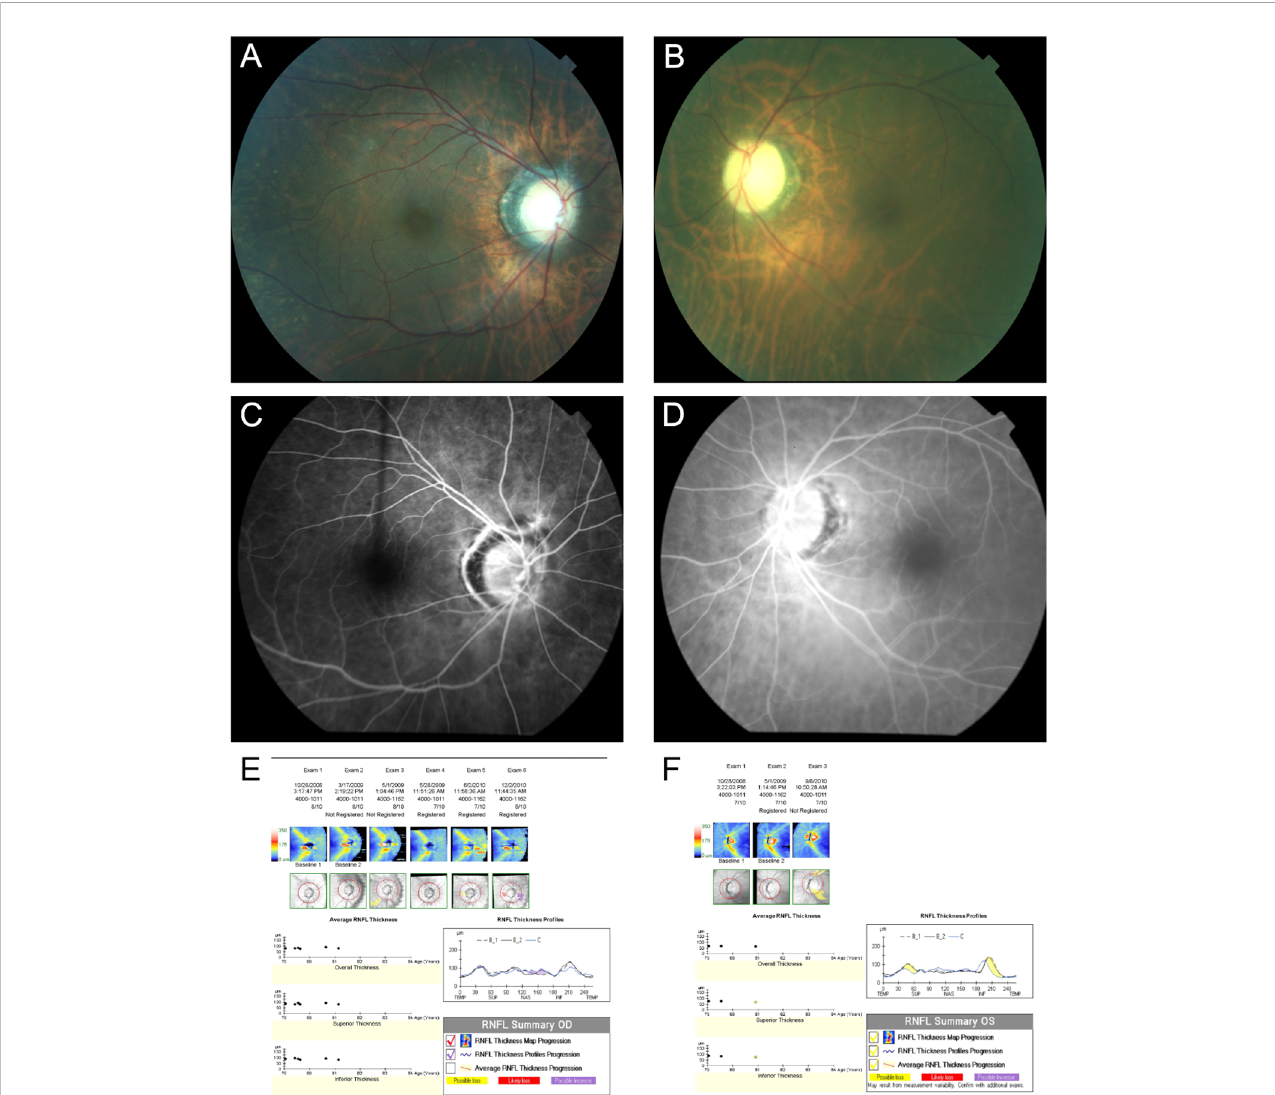
FIGURE 7 Case number 13. Multimodal imaging of a 77-year-old-female with a positive ANA, C3 and C4 SLE along with leukopenia. She presented with acute left eye vision loss and superior altitudinal defect despite being on oral prednisone. Fundus photo of the right (A) and Left eye (B) show a normal looking right optic nerve but a pale and atrophic left optic nerve. FA of the right (C) and (D) left eye show normal circulation without delays or leaks, ruling out giant cell arteritis or other vascular causes for the vision loss. The guided progression analysis (GPA) of the right (E) and left eye (F) shows progressive decline in the retinal nerve fi ber layers of the left eye, compatible with